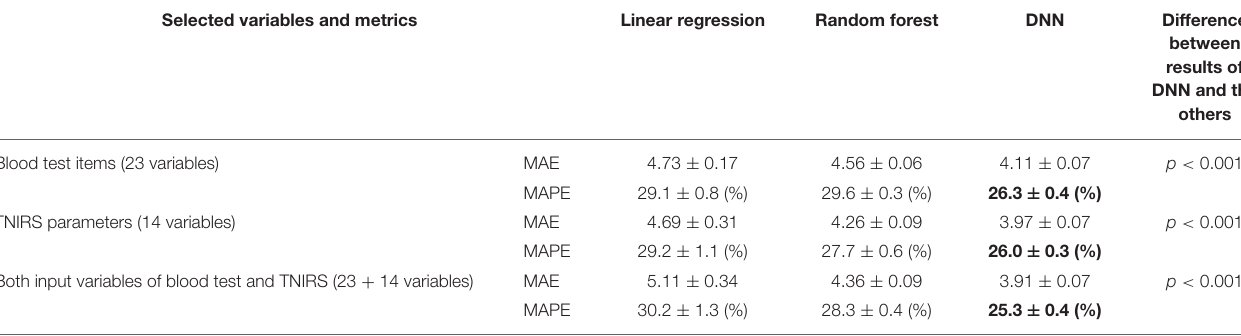
TABLE 5 | Comparison of prediction results (mean values from 10 trials of five-fold cross validation). Selected variables and